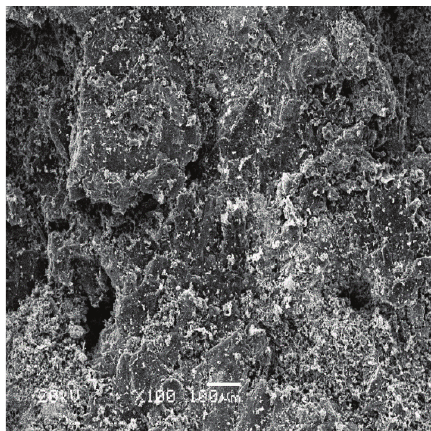
Figure 6: SEM picture of the destroyed lubricous film.